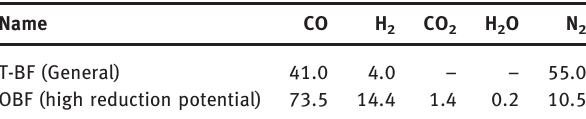
Table 2: The shaft gas composition in OBF and T-BF